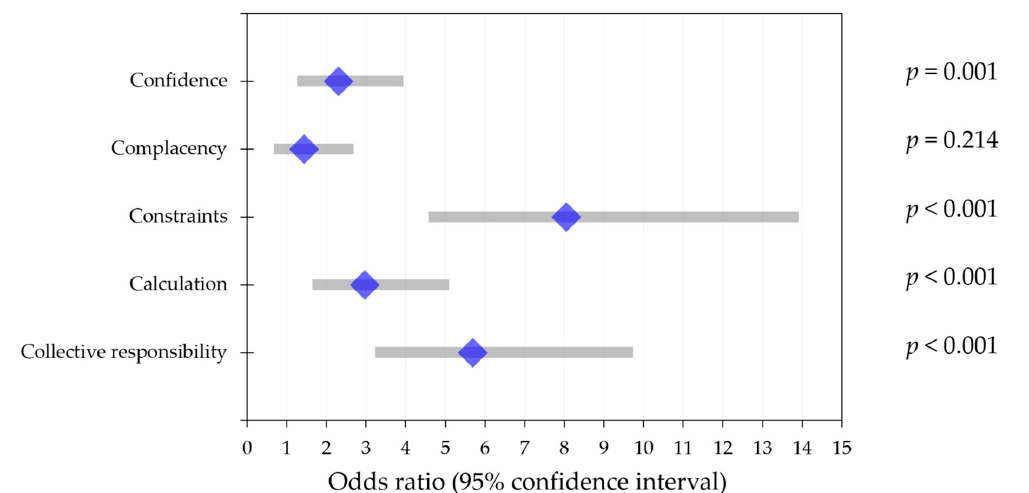
Figure 6. Multinomial regression analysis of the five psychological antecedents (subscales) for COVID-19 vaccine hesitancy and their association with COVID-19 vaccine hesitancy (intent to receive COVID-19 vaccination with no/maybe responses). The mean odds ratio is represented by the diamond blue shape, while the 95% confidence interval is displayed as the grey bar.